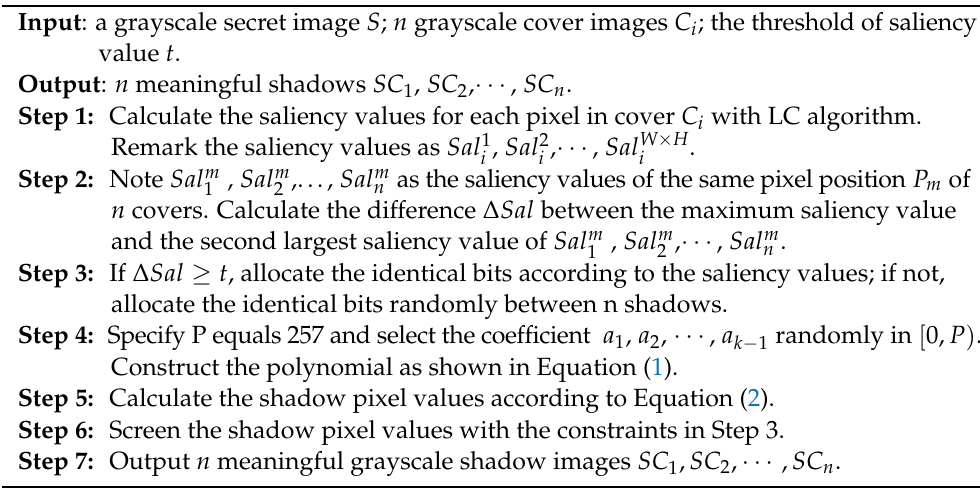
Algorithm 1: The Sharing Phase of Our Proposed